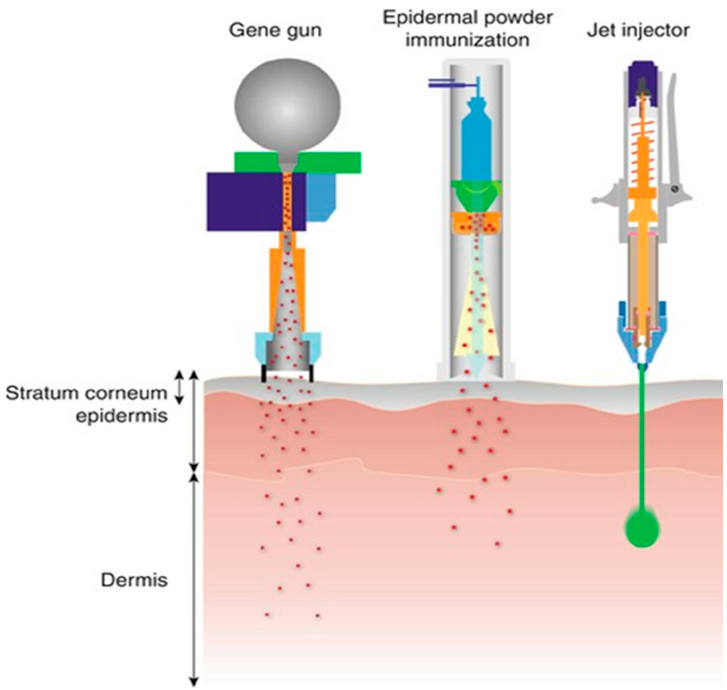
Figure 9. A schematic diagram showing the different types of skin vaccination methods [122]. Table 4. Summary of the different routes of administration for solid dose vaccine delivery and the associated challenges.